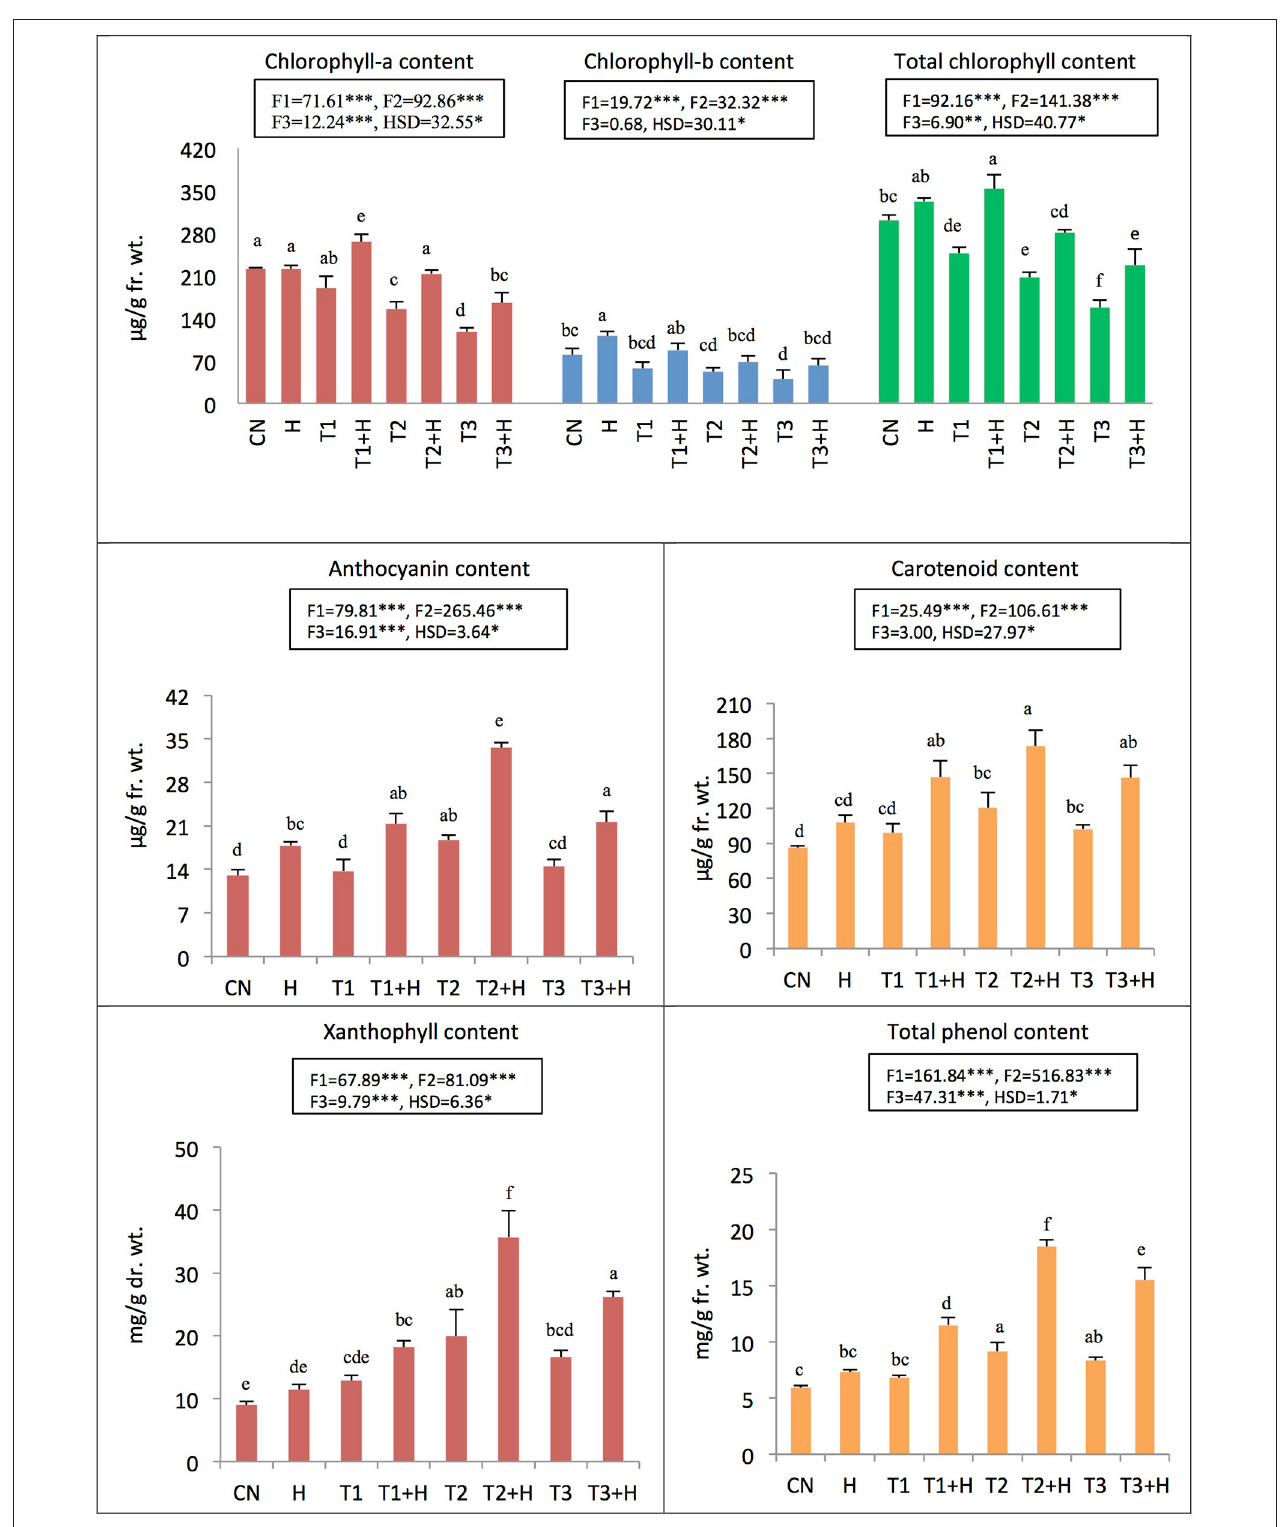
FIGURE 1 | Effect of seed soaking with 24-epibrassinolide (EBR) on pigment and phenol contents in Brassica juncea seedlings grown under imidacloprid (IMI) toxicity. Data are mean ± standard deviation, two-way ANOVA, and Tukey’s HSD (three biological replicates). Treatments with same letter indicates no significant difference at p < 0.05. F1, F2, and F3 are F-ratios for IMI, EBR, and IMI × EBR, respectively. CN, control; H, 100 nM EBR; T1, 150mg IMI/L DW; T2, 200mg IMI/L DW; and T3, 250mg IMI/L DW. ** and *** indicate significant at p < 0.01 and p < 0.001, respectively.